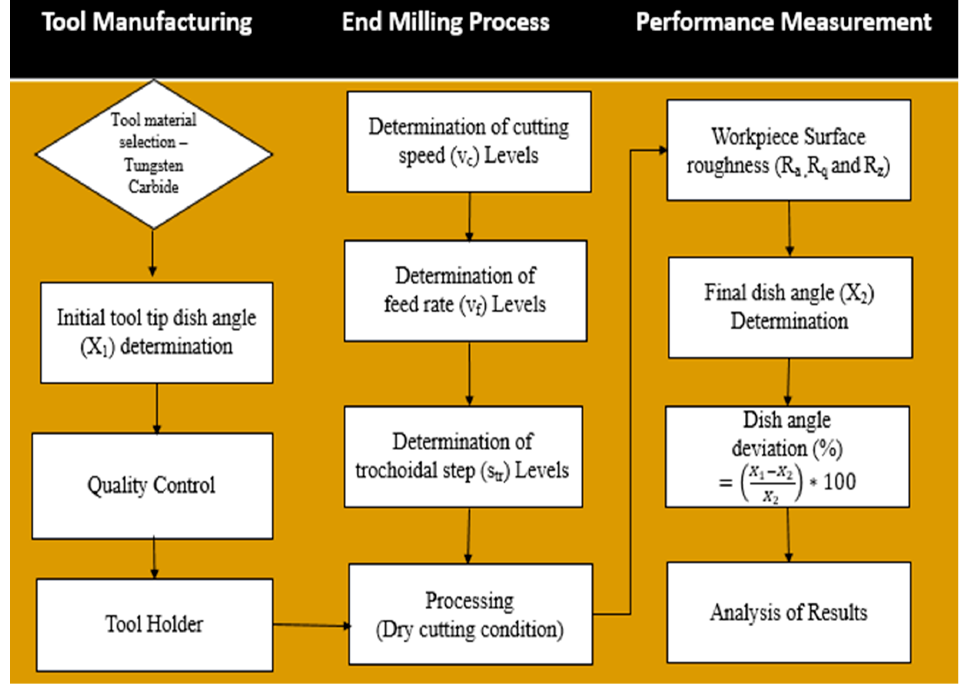
Figure 6. The experimental design procedure for cutting tool performance determination. Table 4. Experimental results for the end milling operation.